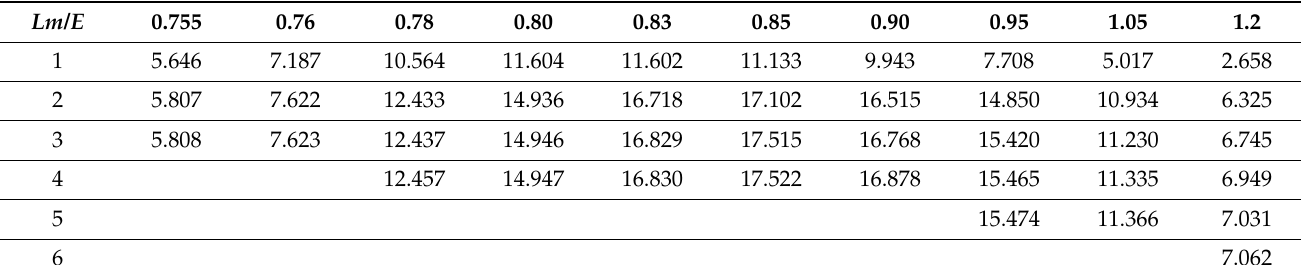
Table 2. Cross sections ( a 2 ) for 1 S to 2 P excitation for various incident energies E (Ry) in the variational 0 polarized approximation.